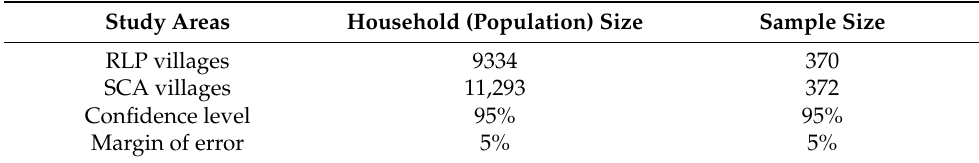
Table 2. Survey sample size calculation. Study Areas Household (Population) Size Sample Size RLP villages 9334 370 SCA villages 11,293 372 Confidence level 95% 95% Margin of error 5%